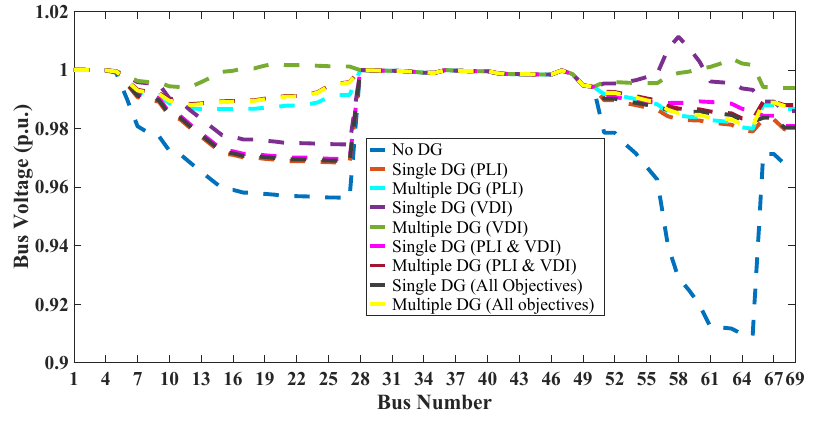
Figure 10. Variation of bus voltage showing effect of objective for constant